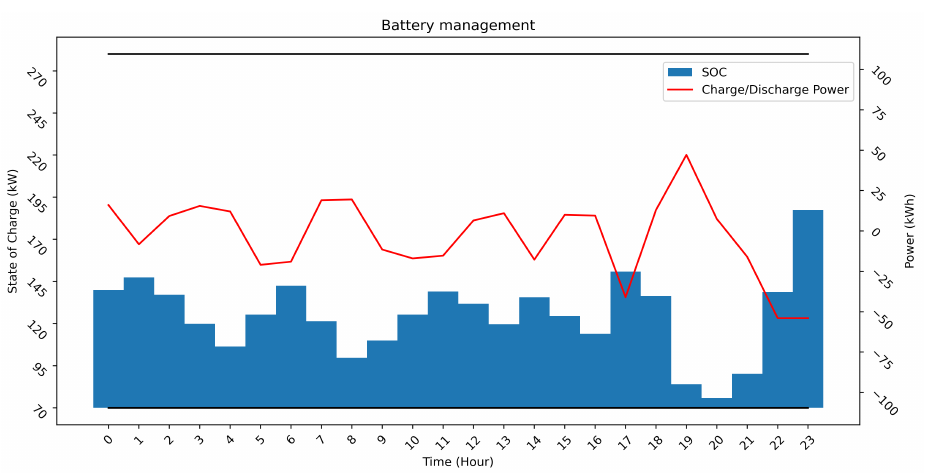
Figure 9. Management of BESS is based on GA approach to case 1.